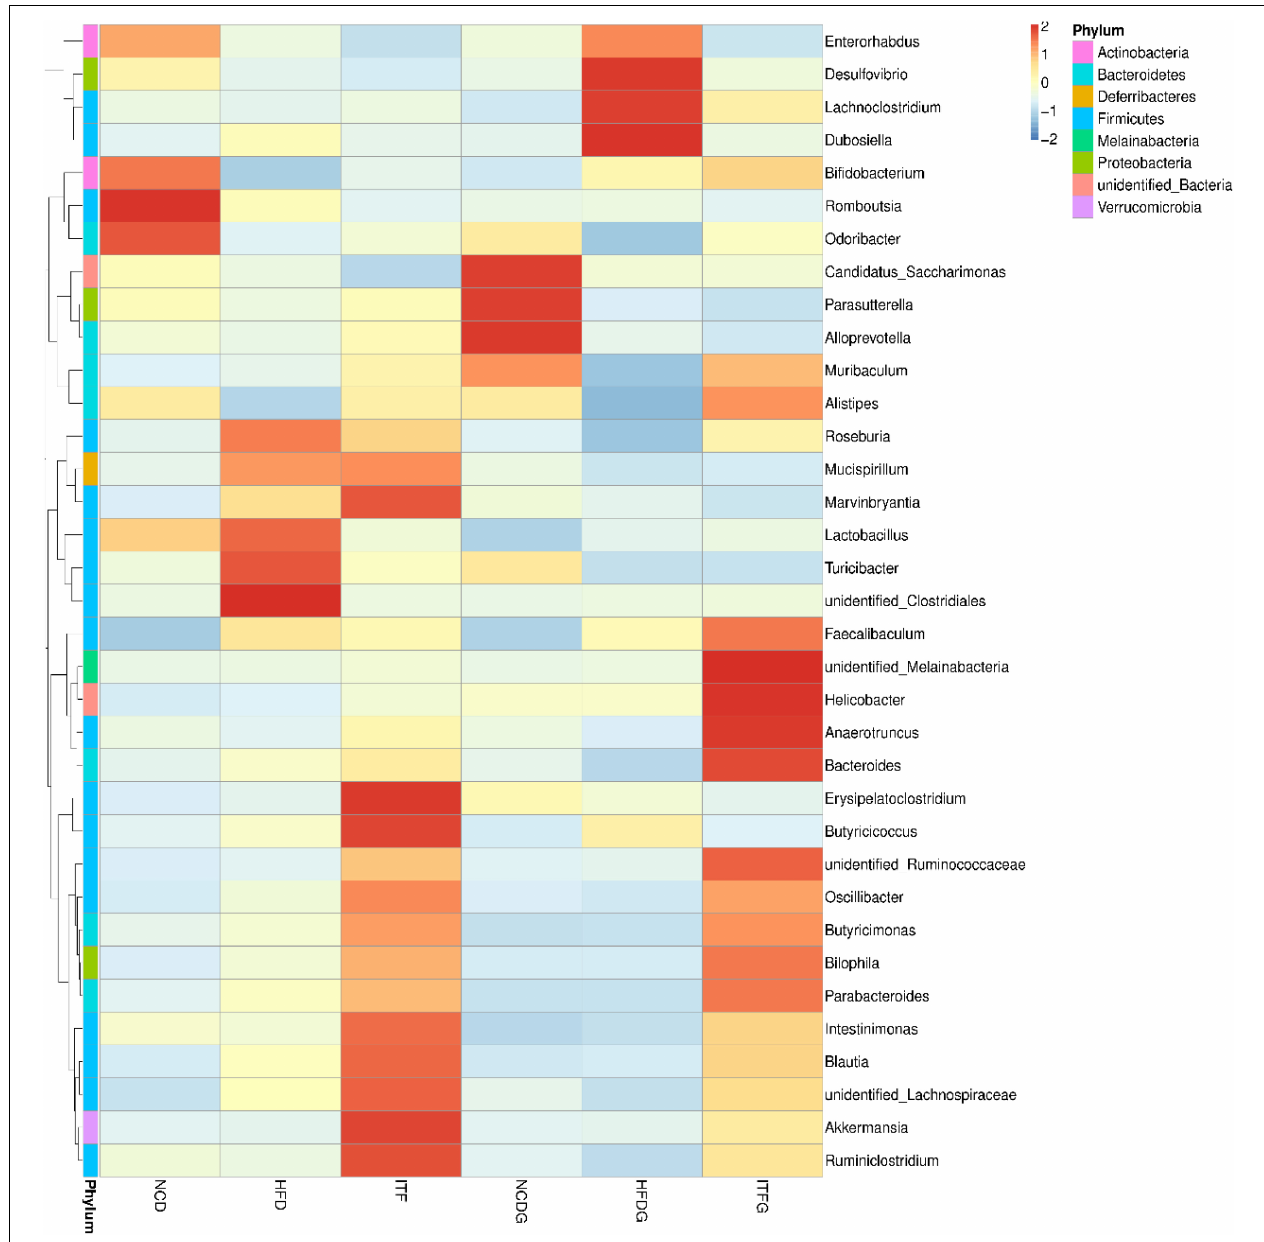
FIGURE 6 | Heat map of microbial species of at the genus level in the feces of